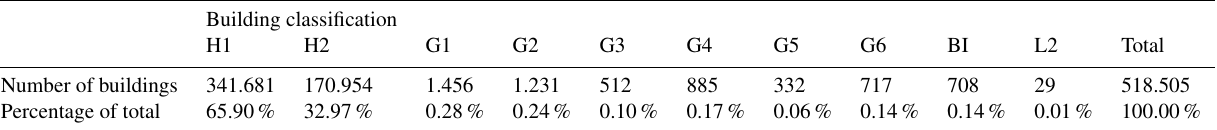
Table 2. OSM data by building